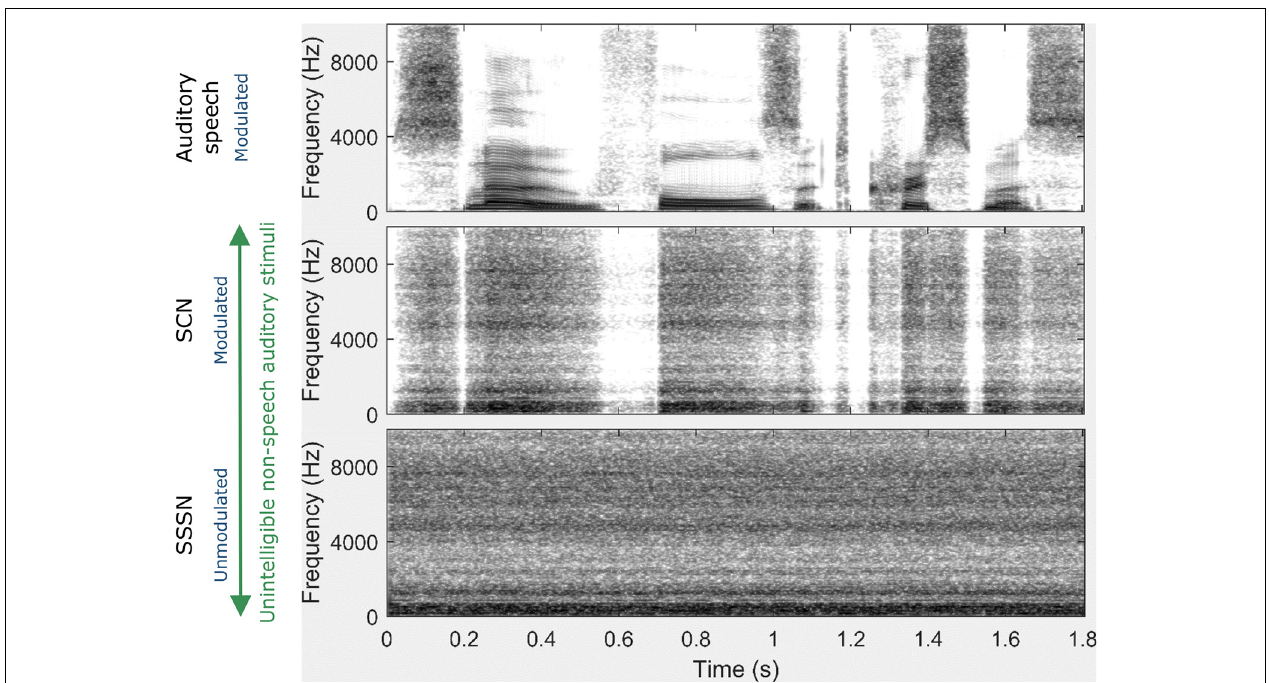
FIGURE 2 | Spectrograms for each auditory stimulation condition for the sentence: Snow falls at Christmas. Unlike the auditory speech condition, there is a constant spread of energy across frequencies (indicated by constant levels of gray over time) in both the signal-correlated noise (SCN) and steady speech-shaped noise (SSSN) conditions. Although amplitude modulation (AM) is preserved in the SCN condition (as shown by the white gaps which mirror the gaps displayed in the auditory speech spectrogram), there is no AM in the SSSN condition.